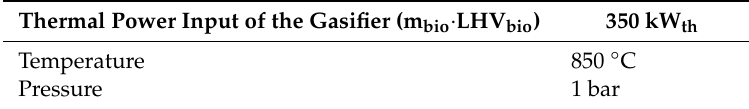
Table 2. Common operating conditions of Aspen Plus and MATLAB